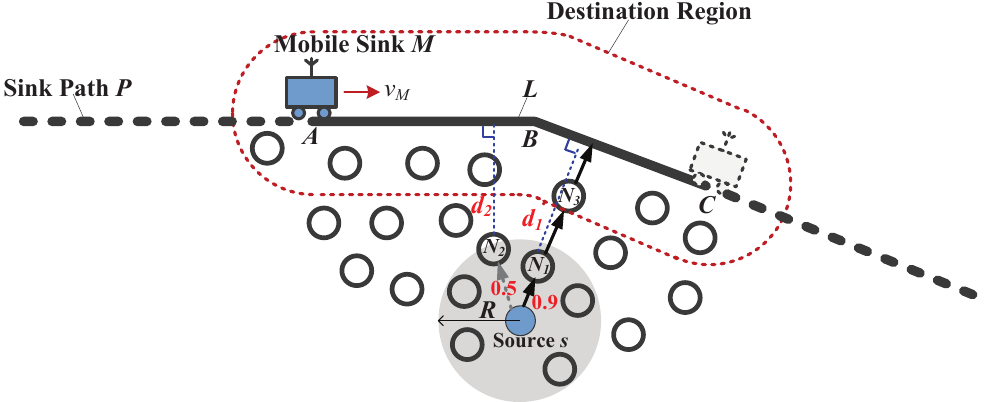
Figure 3. An example of greedy forwarding for